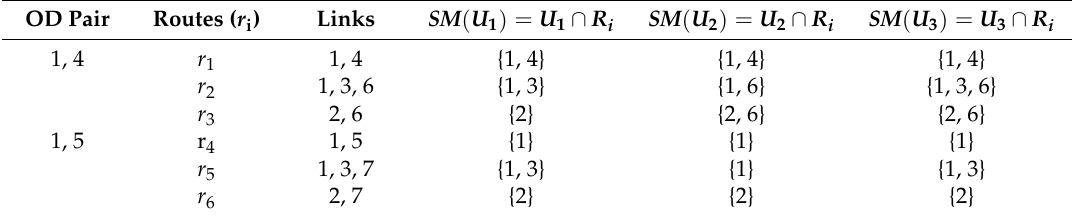
Table 2. Scanning map illustration with U 1 = { 1, 2, 3, 4 } , U 2 = { 1, 2, 4, 6 } and U 3 = { 1, 2, 3, 4, 6 }